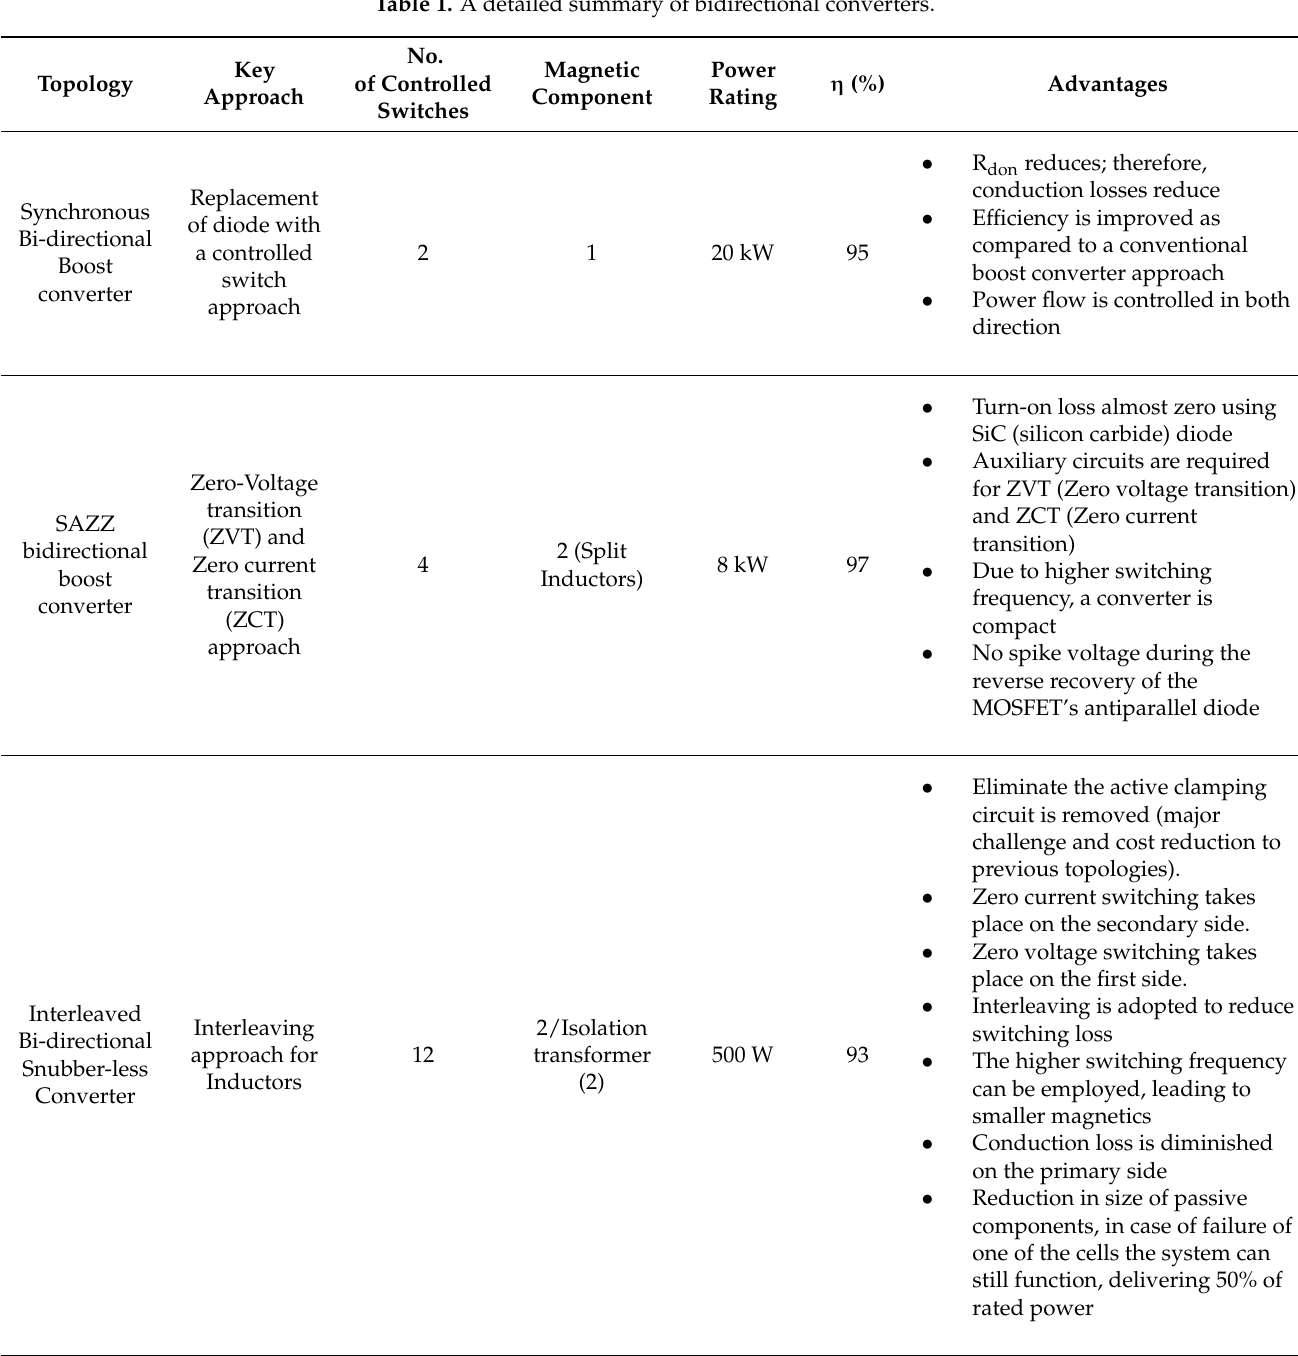
Table 1. A detailed summary of bidirectional